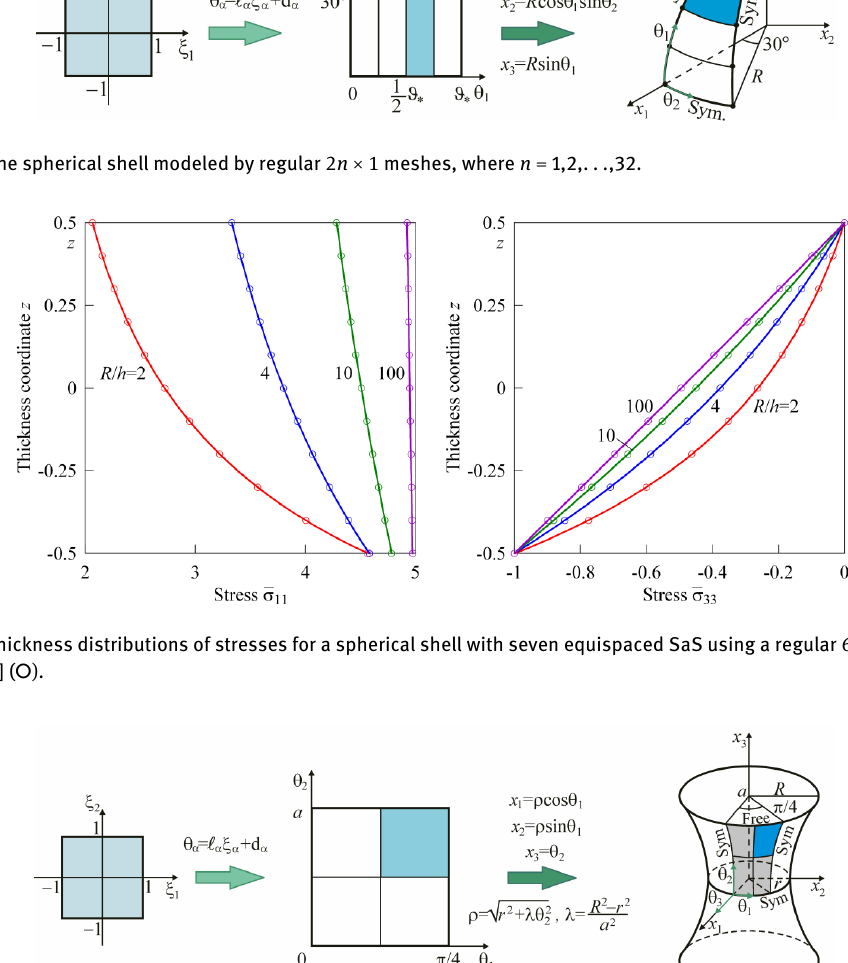
Figure 10: A sixteenth part of the hyperbolic shell modeled by regular 2 n × 2 n meshes, where n = 1,2, . . . .